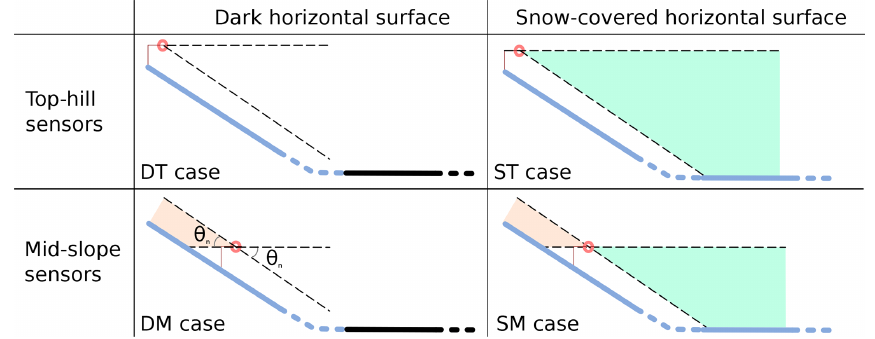
Figure 2. The four studied cases depending on the sensor position (mid-slope, top hill) and surface type of the horizontal surface: snow (blue), dark (black). The neighbourhood (i.e. horizontal surface) is seen by the downward-looking sensor in the lower solid angle (green shading, as in Fig. 1). The upper slope is seen by the upward-looking sensor by the upper solid angle (orange shading). Note that the horizontal surface is infinite and the slope is infinite except in the top-hill